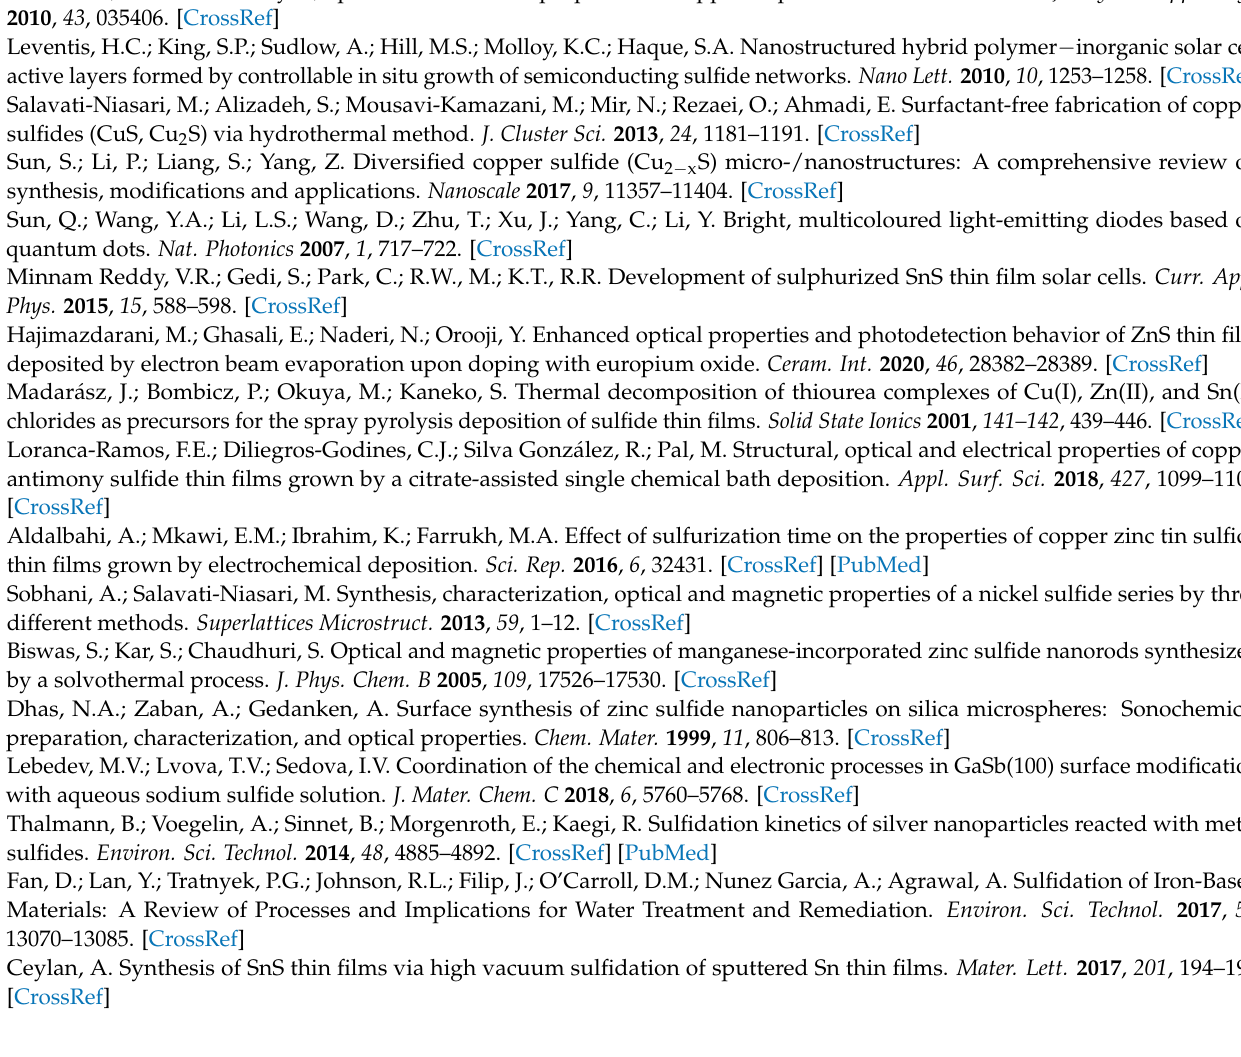
is 1 µ m. Figure S3. Fast Fourier Transform (FFT) patterns of the high-resolution images showing the hexagonal Cu 2 S, α -Cu 2 S, and Cu 1.81 S phases (a) in the 0.5–60 and (b) 10–60 sample in Figure 4. Figure S4. The oxidation states of the Cu films sulfurized for the reaction times of t = 10 and 60 min in the various Na 2 S solution concentrations (c = 0.5, 1, 2.5, 5, and 10 mM). Figure S5. XPS spectra of the samples sulfurized from the Na 2 S solution with different concentrations (c = 0.5–10 mM) for reaction times of t = 10 and 60 min: the S 2 p region of the samples reacted for (a) 10 min and (b) 60